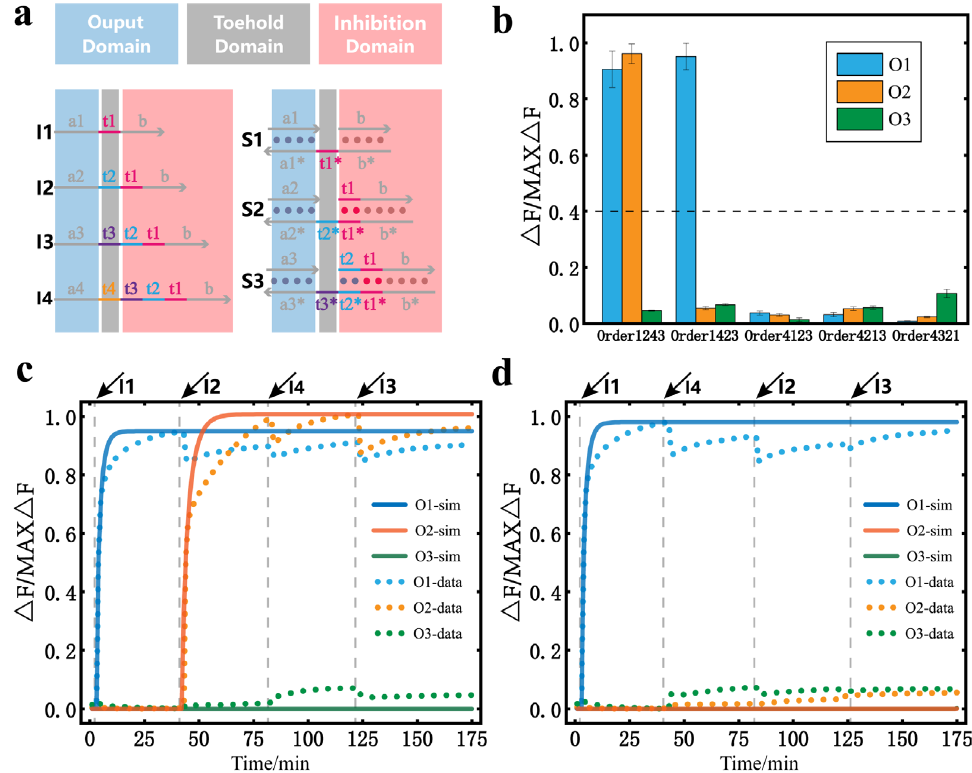
Figure 4. DNA temporal logic circuit with four inputs and three substrates. ( a ) Design of the temporal logic circuit with four inputs and three substrates. ( b ) Bar graph of the output fluorescence signal with different orders of inputs. The dashed line marks the separation between the output results 0 and 1. ( c ) The curve of the fluorescence data and simulation data when the order of inputs is I1, I2, I4, and I3 and the interval of input addition is 40 min ([S1] = [S2] = [S3] = 120 nM, [I1] = [I2] = [I3] = 400 nM). ( d ) The curve of the fluorescence data and simulation data when the order of inputs is I1, I4, I2, and I3 and the interval of input addition is 40 min ([S1] = [S2] = [S3] = 120 nM, [I1] = [I2] = [I3] = 400 nM). All the asterisks in the figure indicates the complementary strand of the corresponding strand.